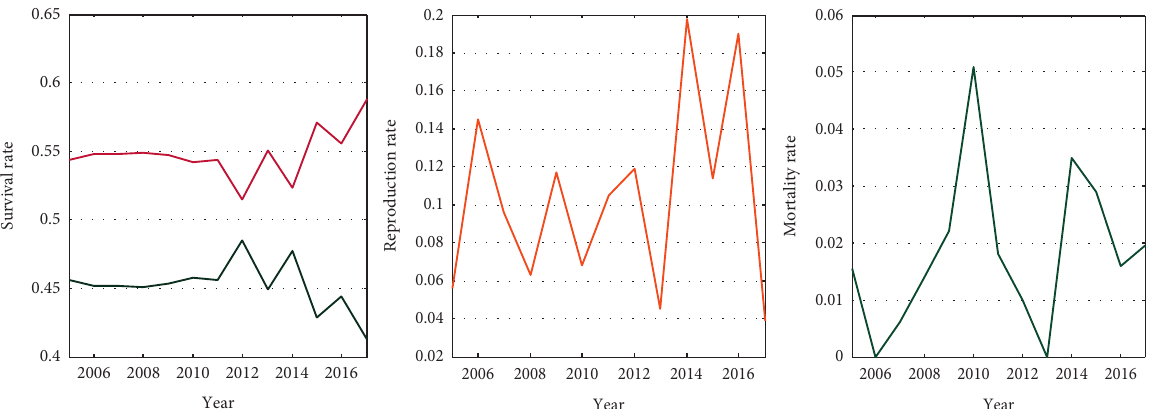
Figure 5: The statistical survival rate, reproduction rate, and mortality rate of endangered giant pandas from GPBB for 13 years from 2005 to 2017, given three group trajectories reflecting the dominant cause of changes in population size: natural factors; human behaviour; or enigmatic factors. The purpose of three graphs is to offer the basis reference for setting parameters in the process of running PDP systems such that the data in Table 3 are tuned on the basis of Figure 5. (a) Survival rate ranges. (b) Reproduction rate ranges. (c) Mortality rate ranges.